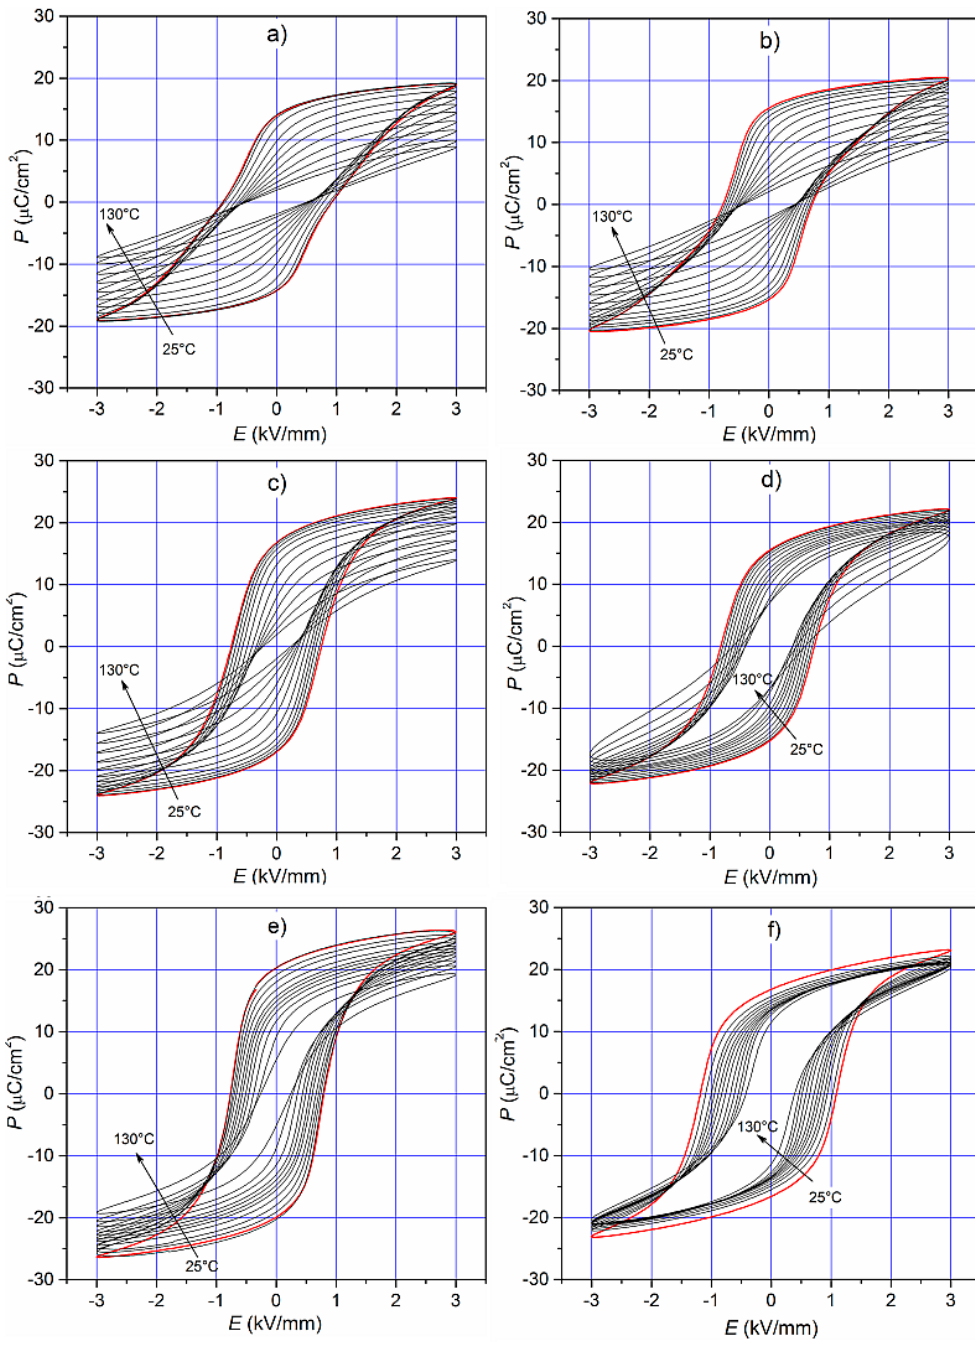
Figure 9. The hysteresis loops for PMN–PT–PS samples at various temperatures: ( a ) PPP0.25; ( b ) PPP0.28; ( c ) PPP0.31, ( d ) PPP0.34; ( e ) PPP0.37; and ( f ) PPP0.40 (frequency 1 Hz).